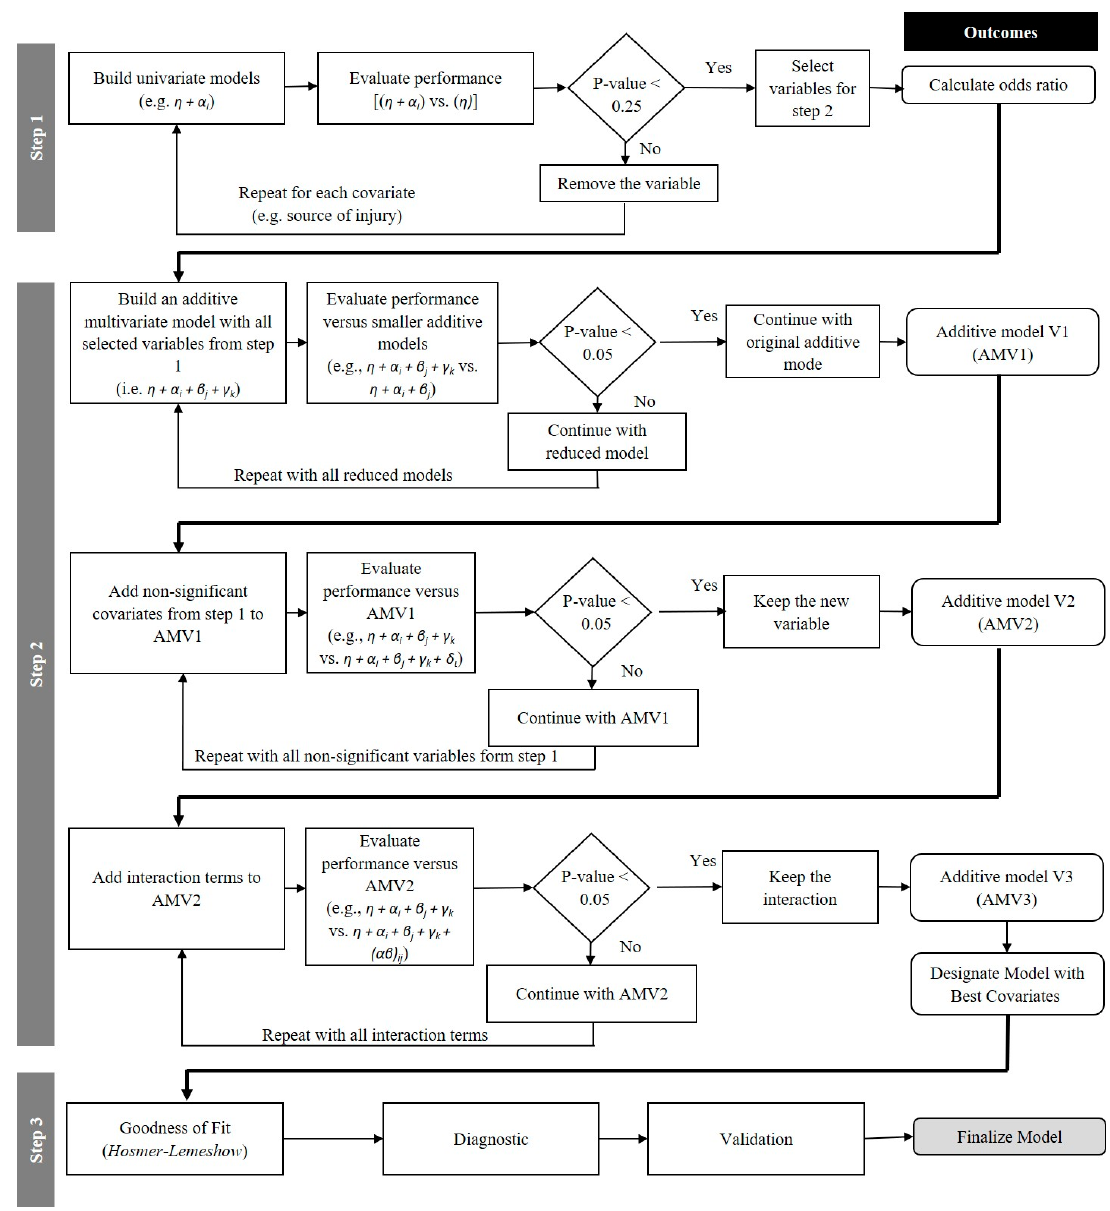
Figure 1. Three steps of building and validating a multivariate logistic regression model.